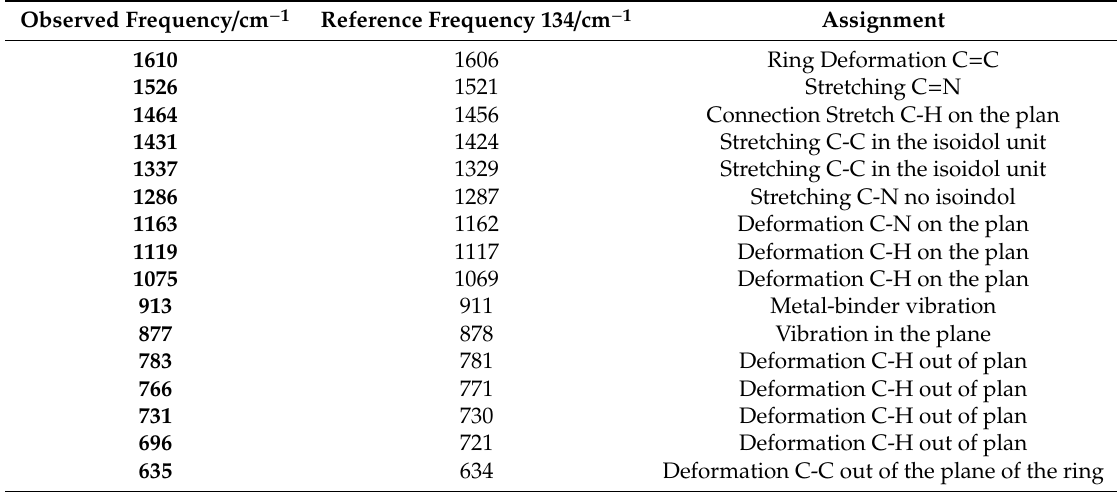
Figure 7. Infrared spectra ( a ) MWCNT; ( b ) CoPc and ( c ) MWCNT-CoPc. Table 2. Assignment of vibrations to cobalt phthalocyanine.